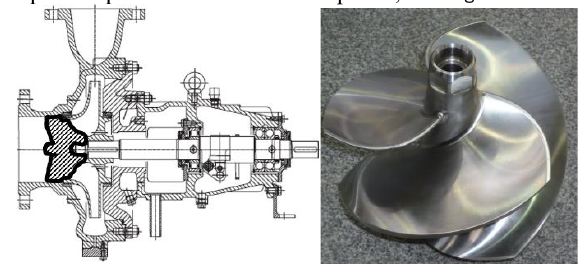
Fig. 6. Inducer (bold black line) placed in front of impeller in centrifugal pump [2] and photo of